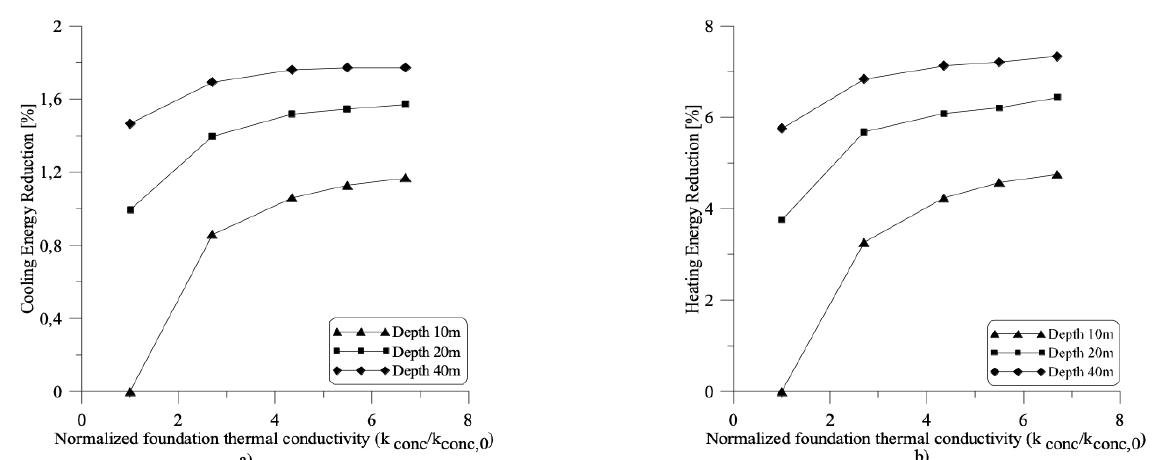
Figure 2. Cooling (a) and heating (b) energy usage of a building in Chicago compared to di ff erent concrete thermal conductivities (image reprinted from [6] and